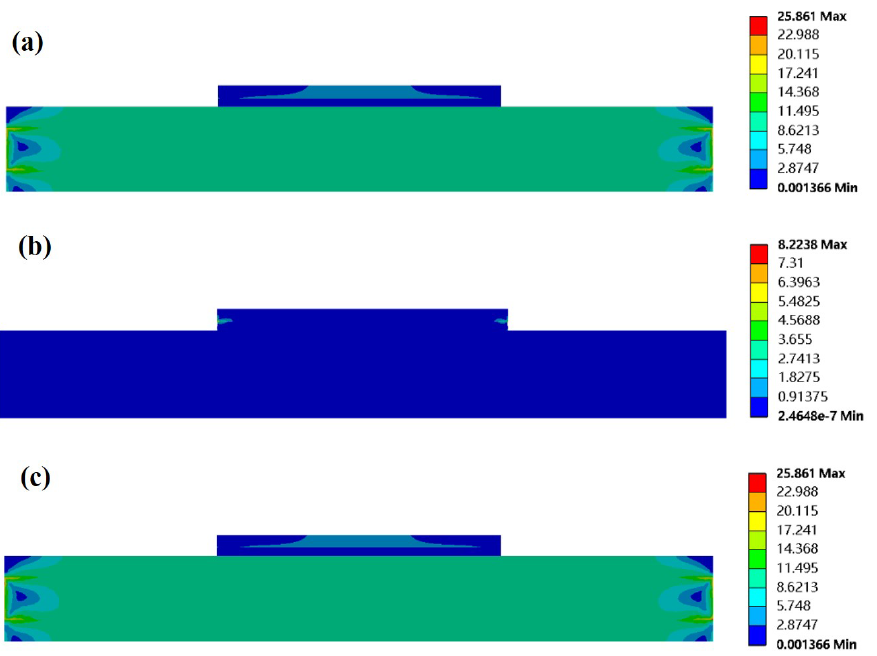
Figure 8. The stress contour plots of model III corresponding to the points ( a ) A, ( b ) B and ( c ) C in the stress recovery peak under the non-fixed